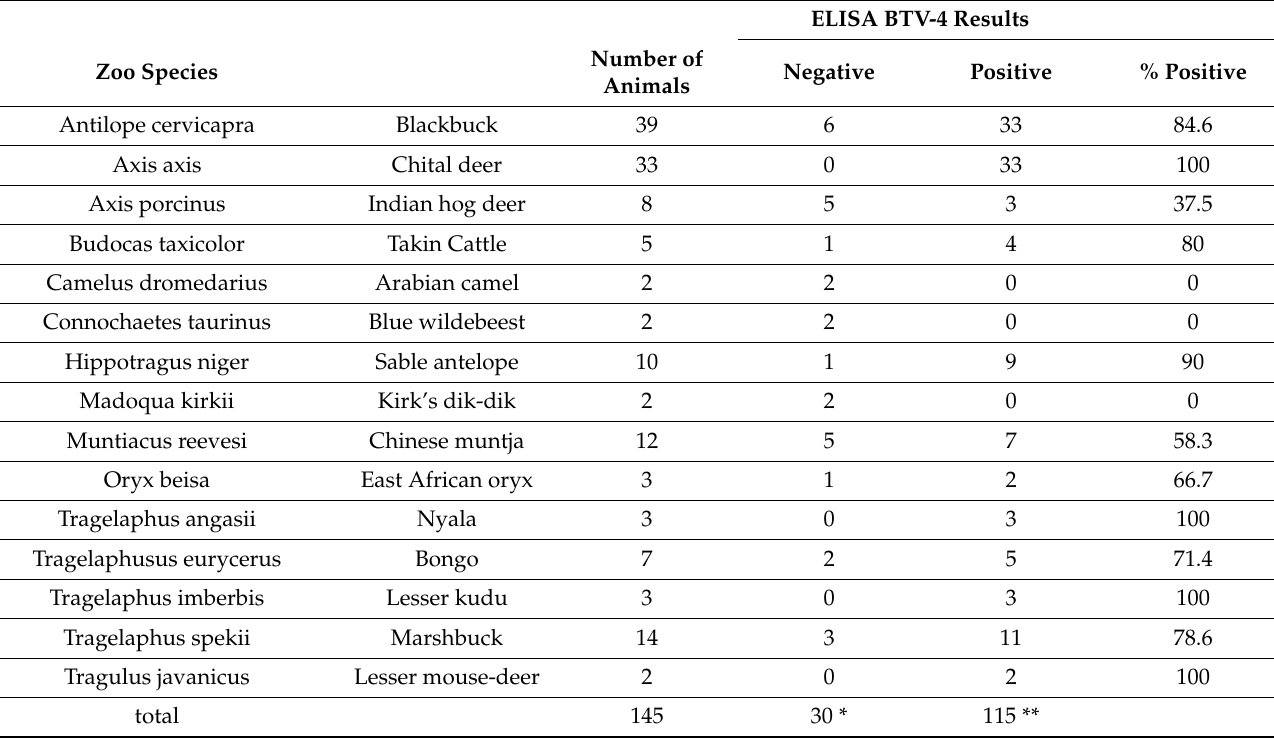
Table 4. BTV-4 ELISA results from 15 zoo